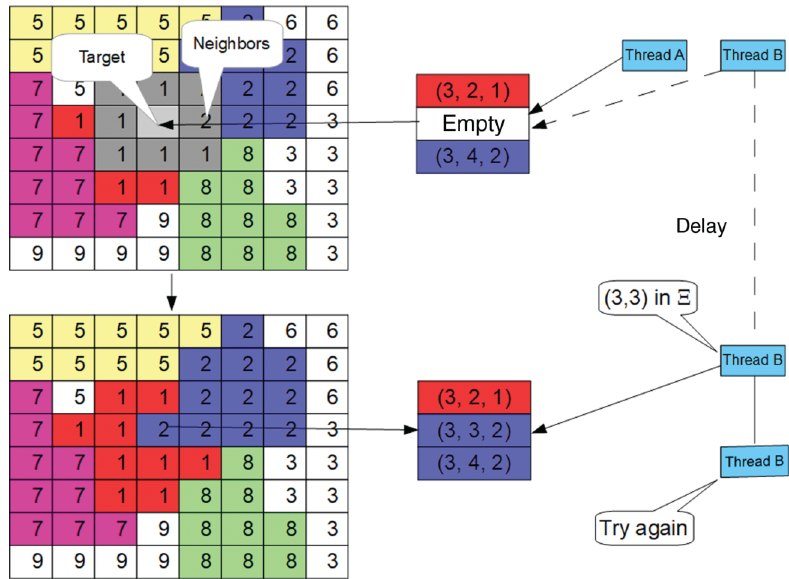
Figure 5: Safe parallel computing.